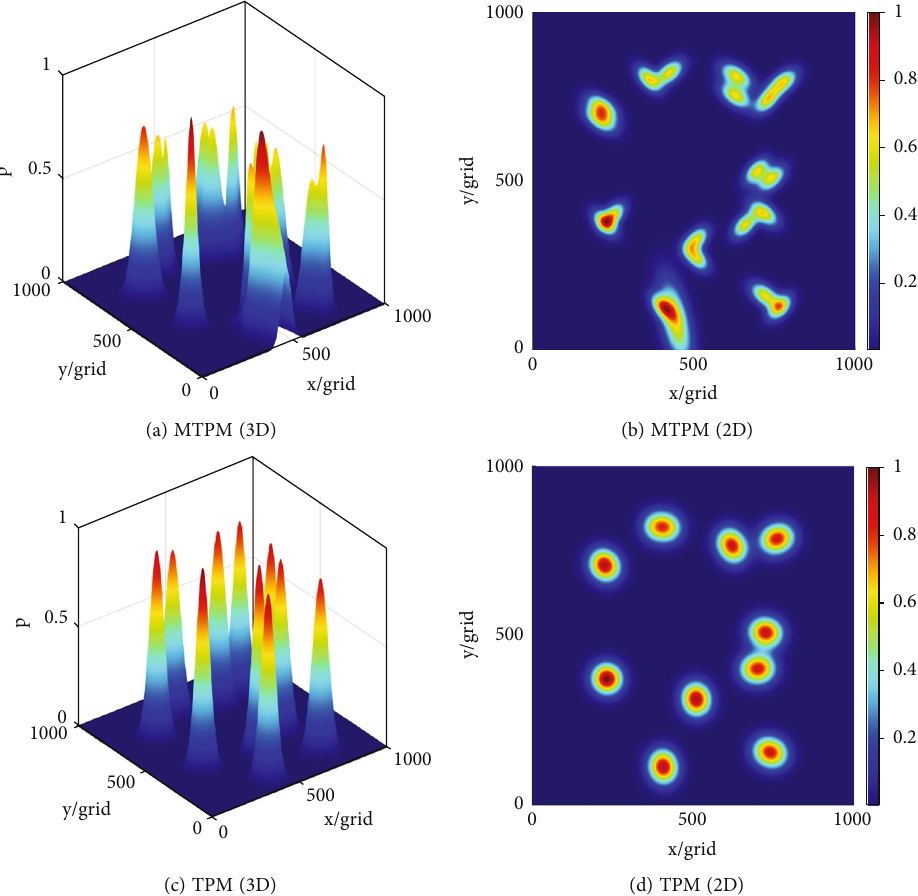
Figure 3: The initial distribution of target probabilities ( k = 0 ).